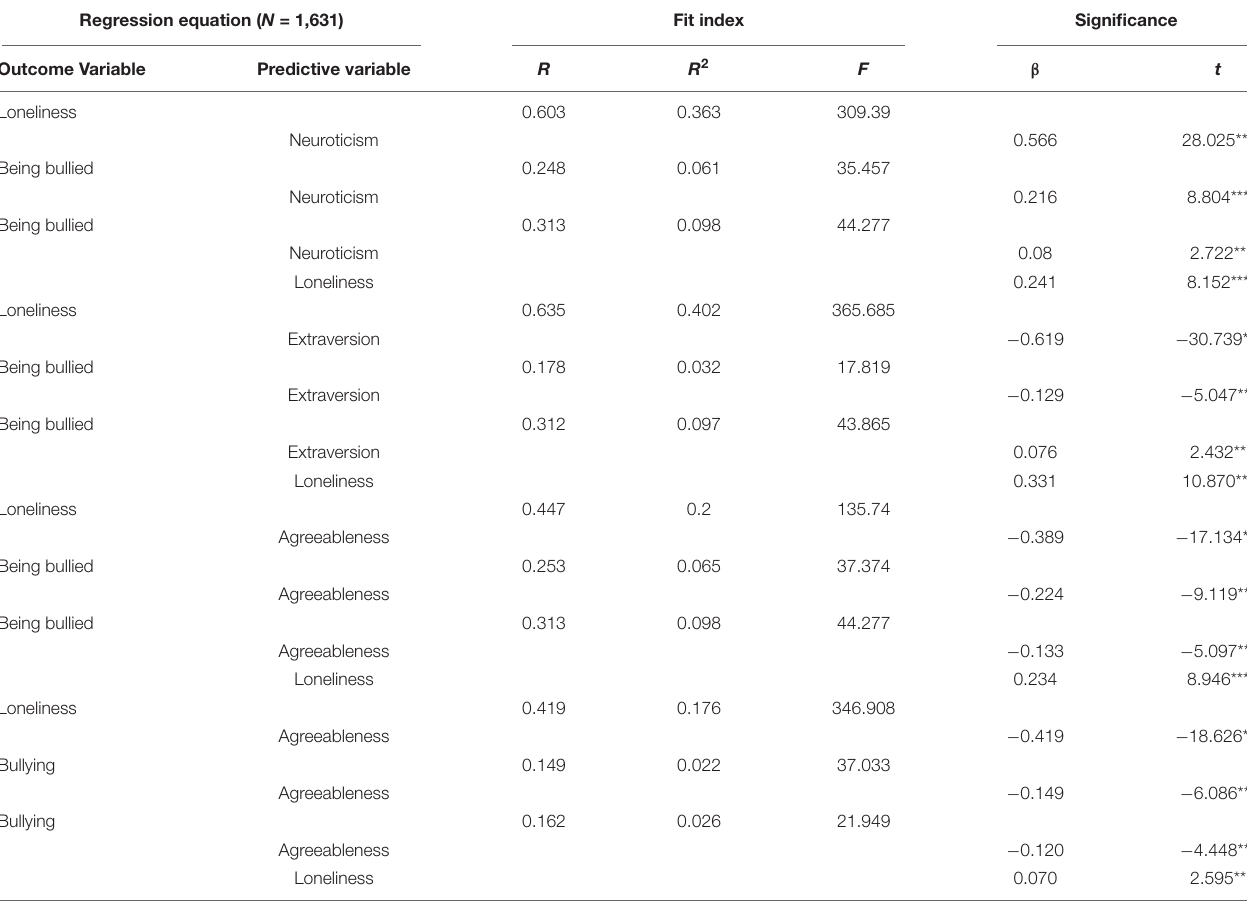
TABLE 2 | Test of the moderated mediating model of loneliness. Regression equation ( N = 1,631) Fit index